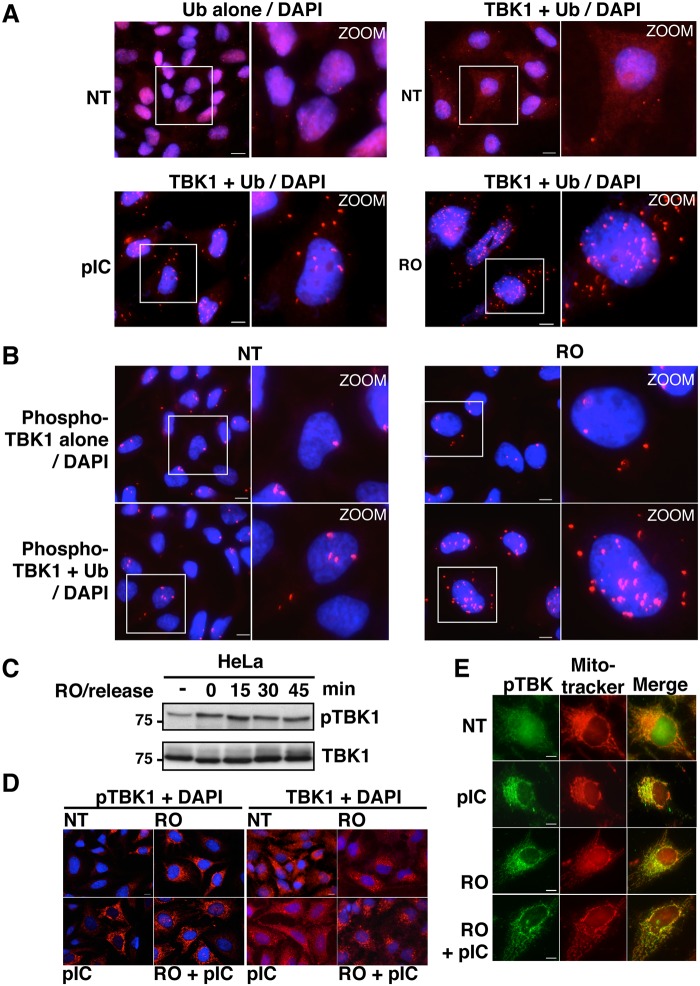
Activity and subcellular localization of TBK1 are altered in G2/M synchronized cells.(A) HeLa cells, left untreated (NT), stimulated by poly(I):poly(C) (pIC) or synchronized in G2/M by RO-3306 (RO), were analyzed by PLA using anti-ubiquitin antibodies alone (upper left panels) or in combination with anti-TBK1 antibodies. Magnified views (x5 zoom factor) of the white square area are presented. Bars = 10 μm. (B) HeLa cells left untreated (NT) or synchronized in G2/M by RO-3306 (RO) were analyzed by PLA using anti-pS172 TBK1 alone (upper panels) or in combination with anti-Ub antibodies. Magnified views (x5 zoom factor) of the white square area are presented. Bars = 10 μm. (C) Cell lysates from HeLa cells, treated with RO and released for the indicated periods of time (min), were immunoblotted with anti-pS172 TBK1 and anti-TBK1 antibodies. (D) Changes in localization of pS172-TBK1 (left panels) and total TBK1 pool (right panels) were monitored by immunofluorescence microscopy in HeLa cells untreated (NT) or synchronized by RO-3306 (RO) treatment and stimulated or not by poly(I):poly(C) (pIC). Bars = 10 μm. (E) Co-localization of pS172-TBK1 and mitochondria was performed by immunofluorescence using Mitotracker staining in HeLa cells untreated (NT) or synchronized by RO-3306 (RO) treatment and stimulated or not by poly(I):poly(C) (pIC). Bars = 10 μm.